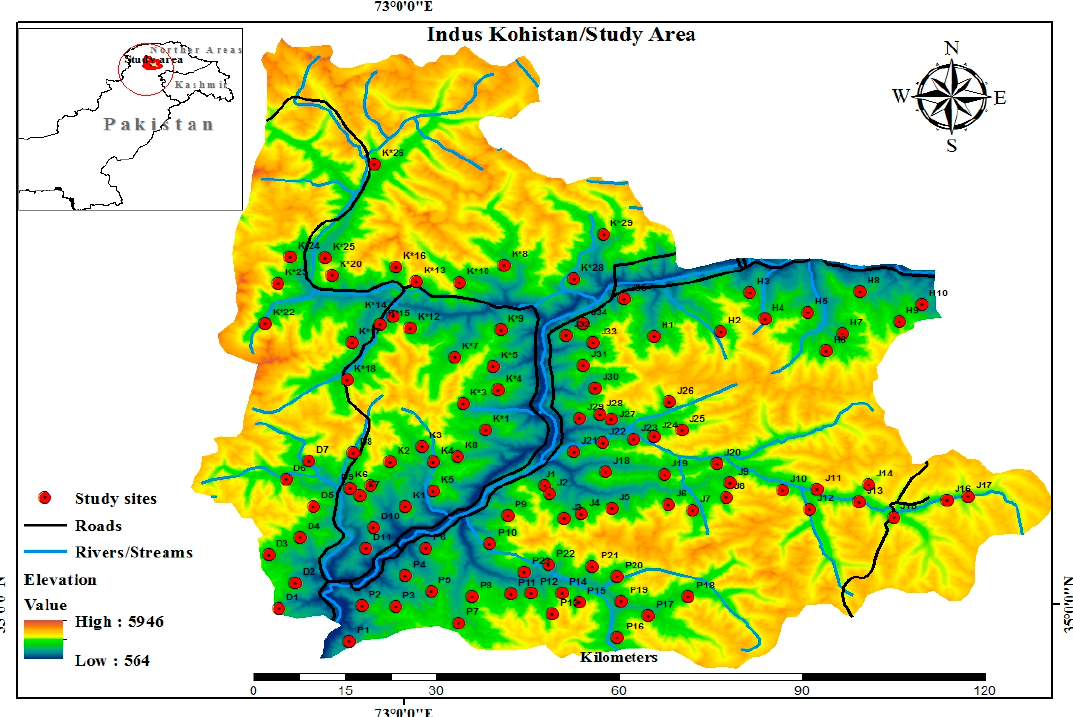
Figure 1. Digital elevation model (DEM) of the study area showing the study sites (vantage points), roads, rivers, and altitudinal variation of the study area.